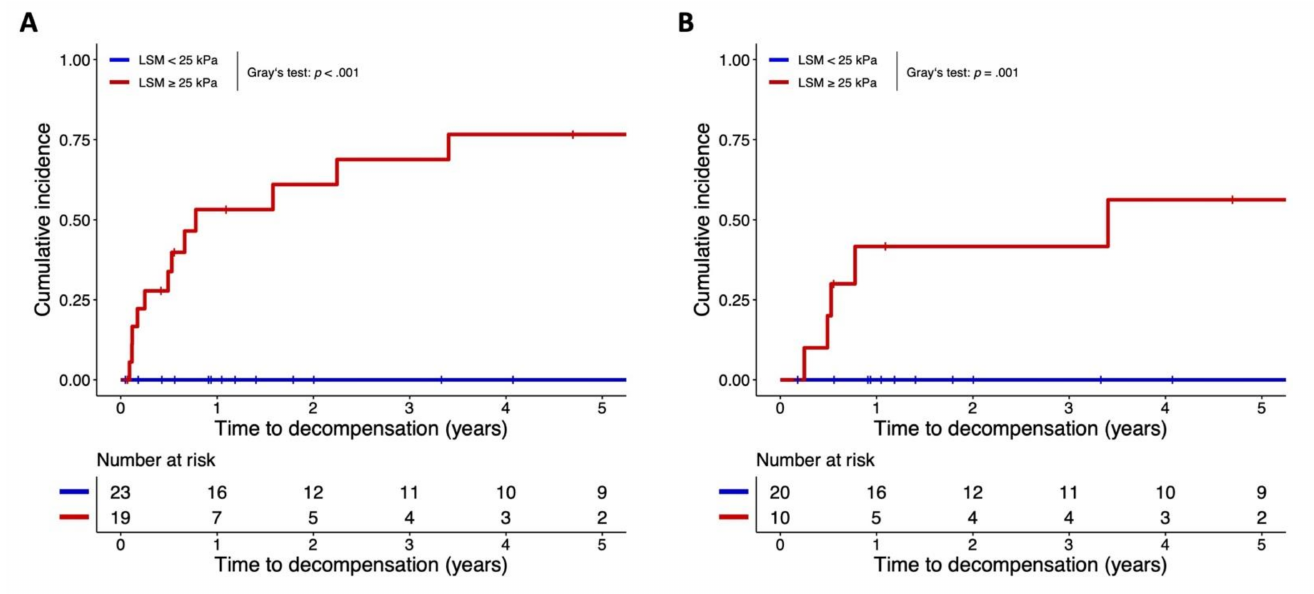
Figure 3. Cumulative incidence of ( A ) (further) hepatic decompensation in the overall cohort and of ( B ) first hepatic decompensation in patients with compensated cirrhosis, stratified by liver stiffness ≥ 25 kPa versus < 25 kPa at follow-up examination. Importantly, HCC diagnosis, liver transplantation and non-liver related mortality were considered as competing risks (graphs not shown). Abbreviations: LSM = liver stiffness measurement; HCC = hepatocellular carcinoma.